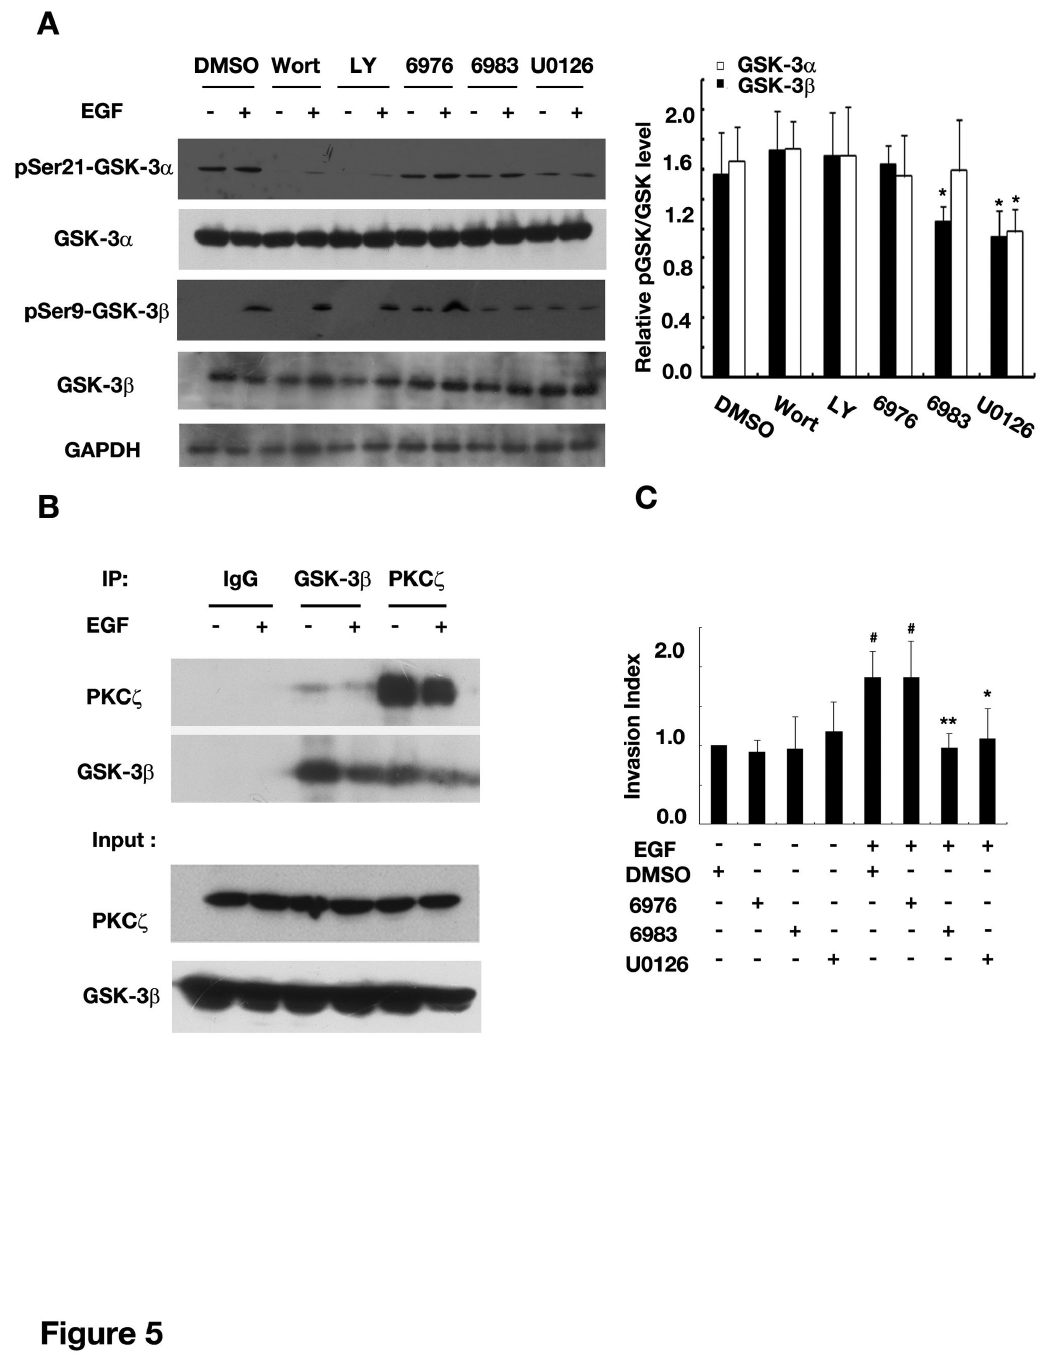
Figure 5. Atypical PKC and MAPK were involved in GSK-3 inactivation in EGF-promoted glioma invasion. (A) EGF-induced increase in pSer-GSK-3 levels was eliminated by inhibitors of aPKC and MAPK. Left : representative western blots of U251 lysates collected 3 hrs after wound recovery in the presence of EGF and indicated agents. Right : quantification of changes in pSer- GSK-3levels normalized to GSK-3 levels and then compared with the group without EGF treatment. (B) BothGSK-3β and PKCζ were present in the same complexes. Western blot analysis of the complexes precipitated by the indicated antibodies (U251 lysates collected at 2 hrs after EGF stimulation). (C) Inhibition of aPKC and MAPK suppressed U87 cell invasion in the transwell assay. # P <0.05 versus DMSO; * P <0.05, ** P <0.01 versus DMSO+EGF. Wortmannin, 1μM; LY294002, 5μM; Gö6976, 0.1μM; Gö6983, 10μM; U0126, 10μM, EGF, 40ng/ml. Data were mean ± SD of three independent experiments in triplicate. doi: 10.1371/journal.pone.0081814.g005 PLOS ONE |